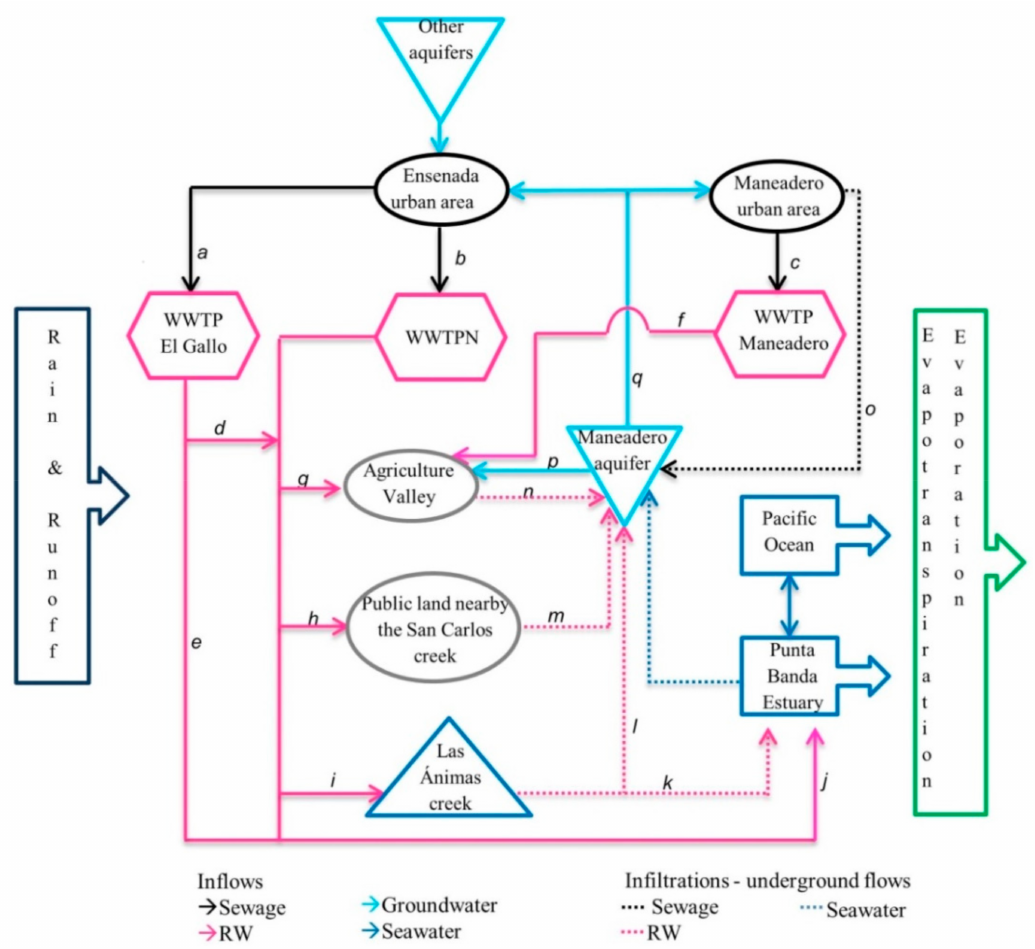
Figure 3. Conceptual model of the water cycle in the Maneadero Valley, where letters in italics refer to the different water types and their corresponding regulation in compliance with the respective Mexican instrument given in Table